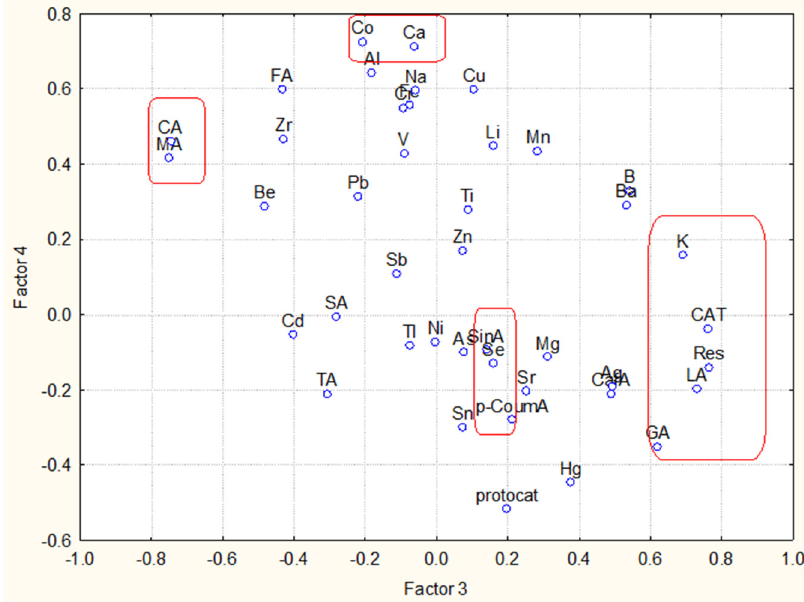
Figure 2. Biplot of factor loadings for factor 3 vs. factor 4.